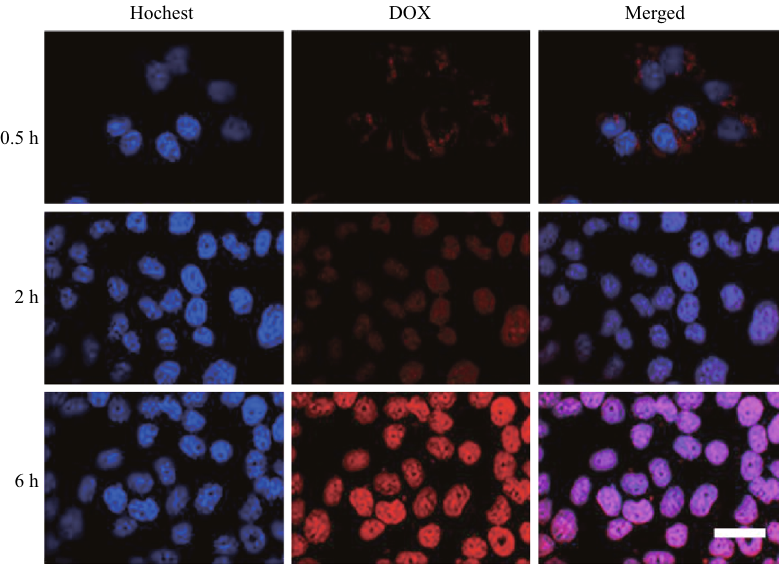
Fig. 4 CLSM images of HeLa cells incubated with DOX-loaded AuNR@PAA/CaP yolk–shell NPs for 0.5, 2, and 6 h (scale bar: 10 l m)